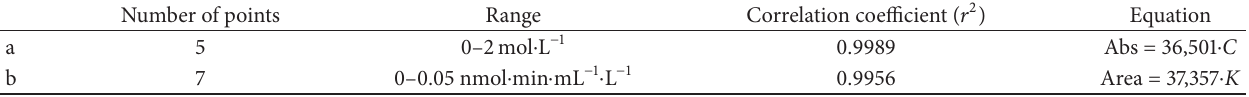
Table 5: Data from linear standard curves, obtained separately by plotting 𝑌 versus 𝑋 .